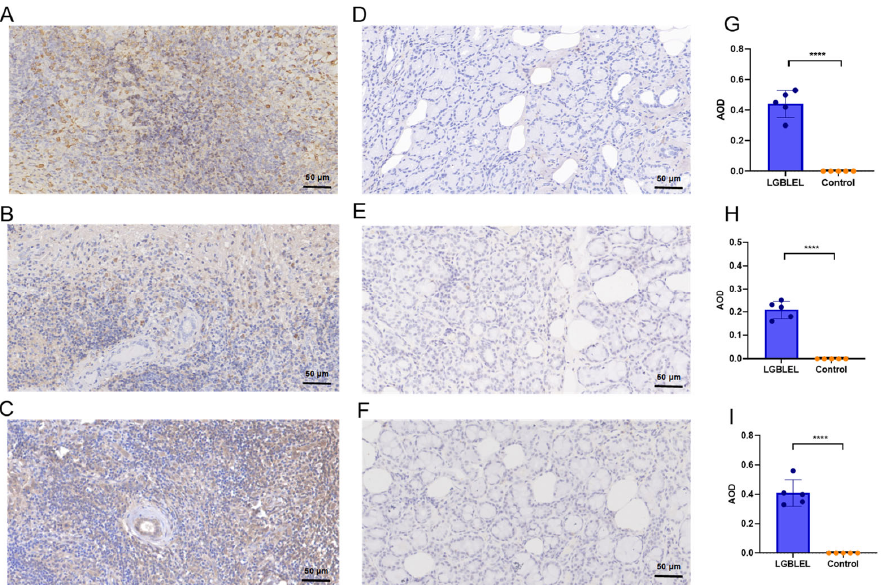
Figure 4. Expression of IgG4, IgG, and C3 in the tissues of patients with LGBLEL and primary lac ‐ rimal prolapse. ( A – C ) The IHC staining representative images of IgG4, IgG, and C3 positive expres ‐ sions in the lacrimal ‐ gland tissues of LGBLEL patients, respectively; ( D – F ) The IHC staining repre ‐ sentative images of IgG4, IgG, and C3 negative expressions in the lacrimal ‐ gland tissues of patients with primary lacrimal prolapse, respectively; ( G – I ) Quantitative analyses of IgG4, IgG, and C3 ex ‐ pressions by IHC, respectively ( n = 5, p < 0.0001). Note: “****” stands for a statistically significant difference.